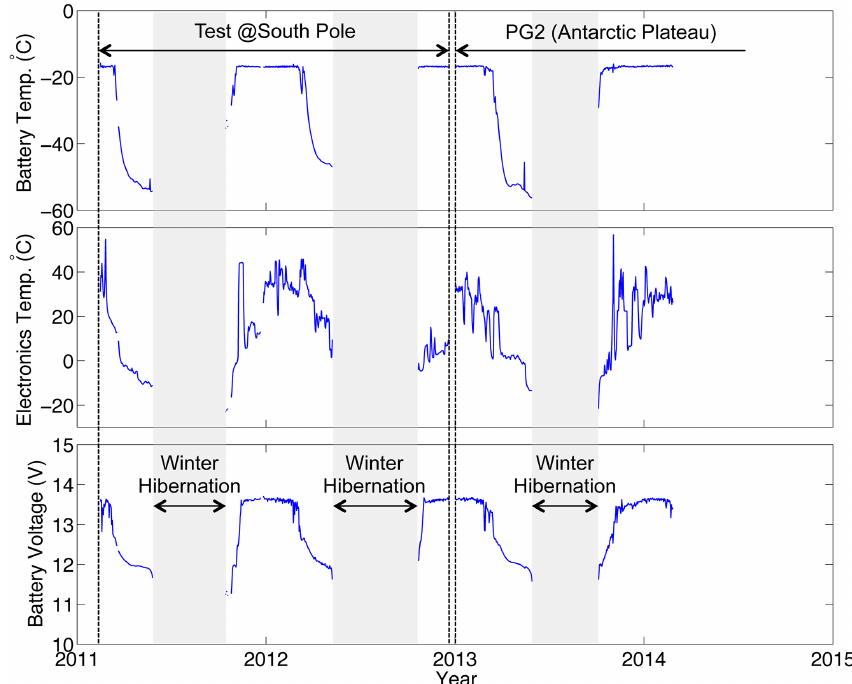
Figure 6. Measured temperature in the battery box (top), temperature in the electronics box (middle) and battery voltage (bottom) from 2011 to the end of February 2014. The AAL-PIP system was designated SYS4 during testing at South Pole station and renamed PG2 after deployment on the East Antarctic Plateau.